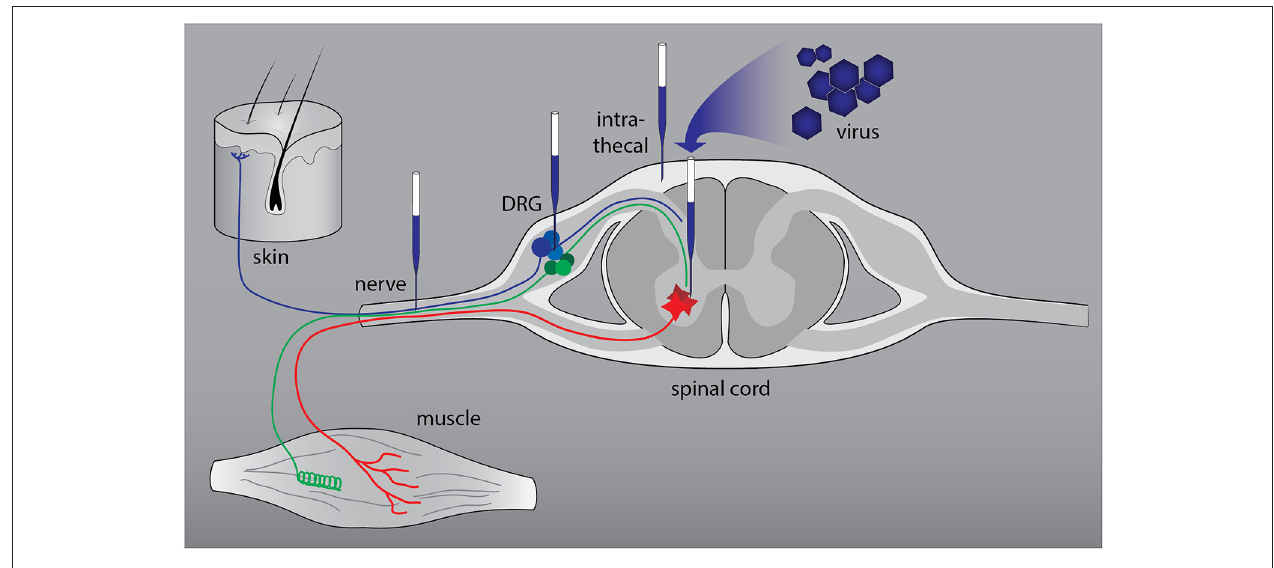
and to Schwann cells, the resident glia cells of peripheral nerves, has been reported with various viral vectors. To target primary sensory and motor neurons two routes of delivery have been used successfully: direct intraganglionic or intraspinal injection and intrathecal (IT) delivery. Injection of a viral vector in the nerve stump distal to the lesion or in a nerve graft that bridges the lesion results in transduction of Schwann